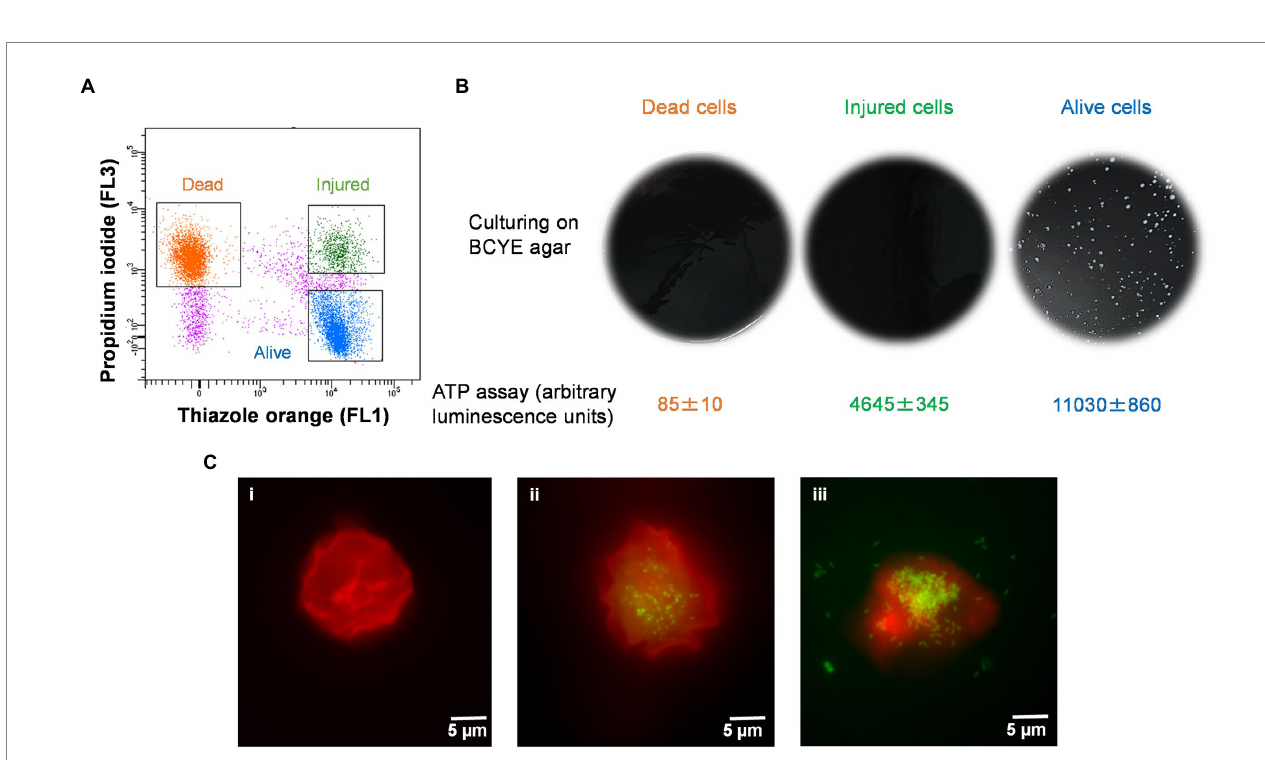
FIGURE 4 Characterization of thermally generated (50 ° C/10 min) VBNC L. pneumophila . (A) Cytogram representing thiazole orange-stained alive (blue), thiazole orange-stained injured (green) and propidium iodide-stained dead (orange) cells generated by 50 ° C heat shock for 10 min. (B) These three fractions were cultured on BCYE agar, and their ATP contents measured using a luciferase-based ATP estimation assay. (C) : FISH of A . polyphaga with Alexa Fluor 647 labeled EUK1209 (red) and Legionella with Alexa Fluor 488 labeled LEG705 (green) probes. (Ci) uninfected A . polyphaga . (Cii,iii) These micrographs show intracellular proliferation of VBNC Legionella within A . polyphaga after 7 and 10 days of infection,